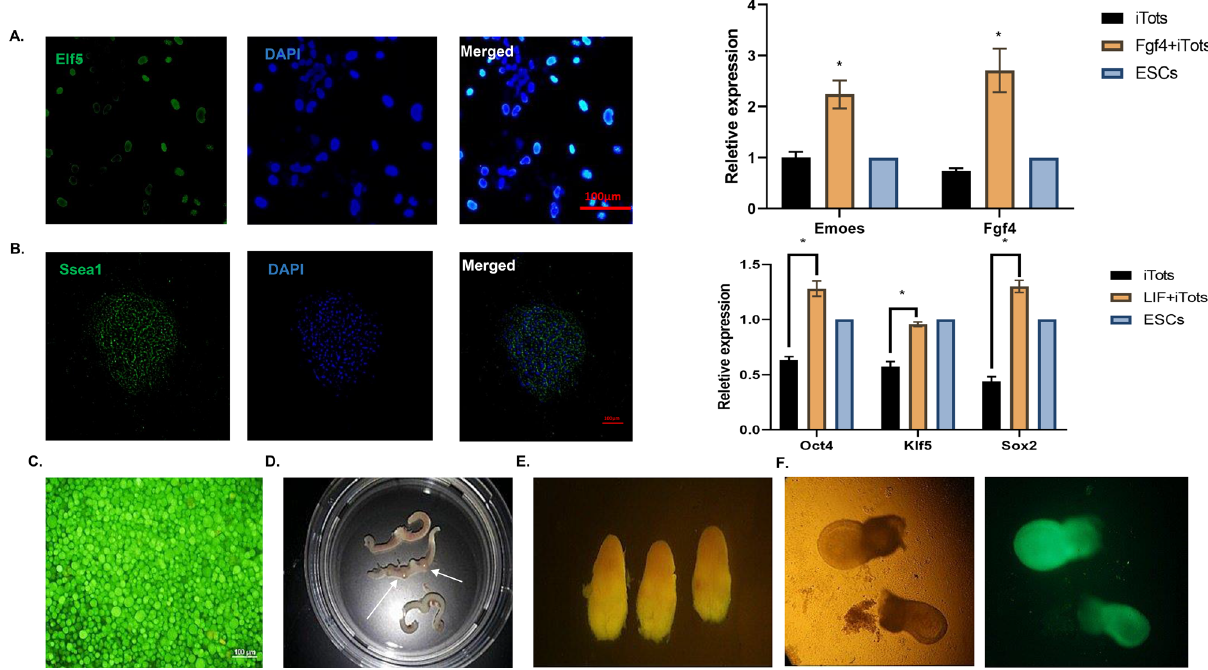
Figure 4. Induced totipotent stem cells show developmental potential. ( A ) ITot cells could be differentiated into trophoblast cells and have higher expression of trophoblast-related gene expression (*P < 0.05). ( B ) ITot cells could be differentiated into pluripotent stem cells and have higher expression of pluripotent-related gene expression (*P < 0.05). ( C ) Induced GFP-positive cells treated with Aza. ( D ) Transfer of Induced GFP-positive cells results in the implantation of cells. ( E ) Transferred cells could develop sacs in the uterus. ( F ) Transferred cells could develop embryo-like